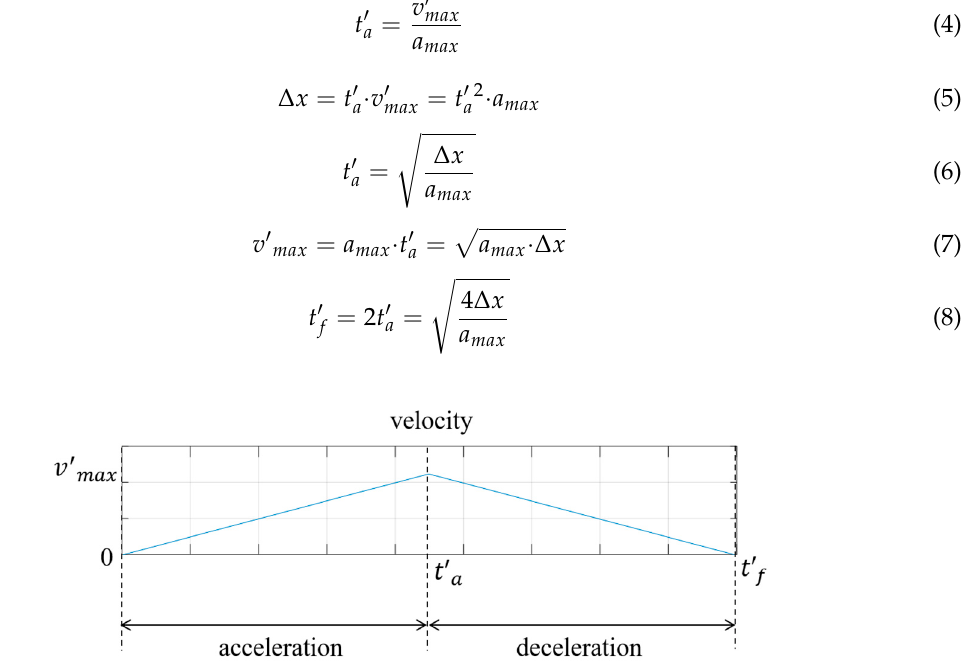
Figure 4. Three sections of trapezoidal motion profile.